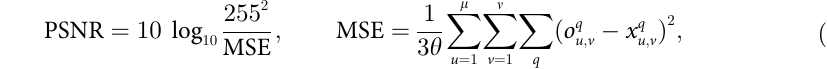
Box plots shown in Fig 2, present the statistical features: median, quartiles: Q 1 and Q 3, and